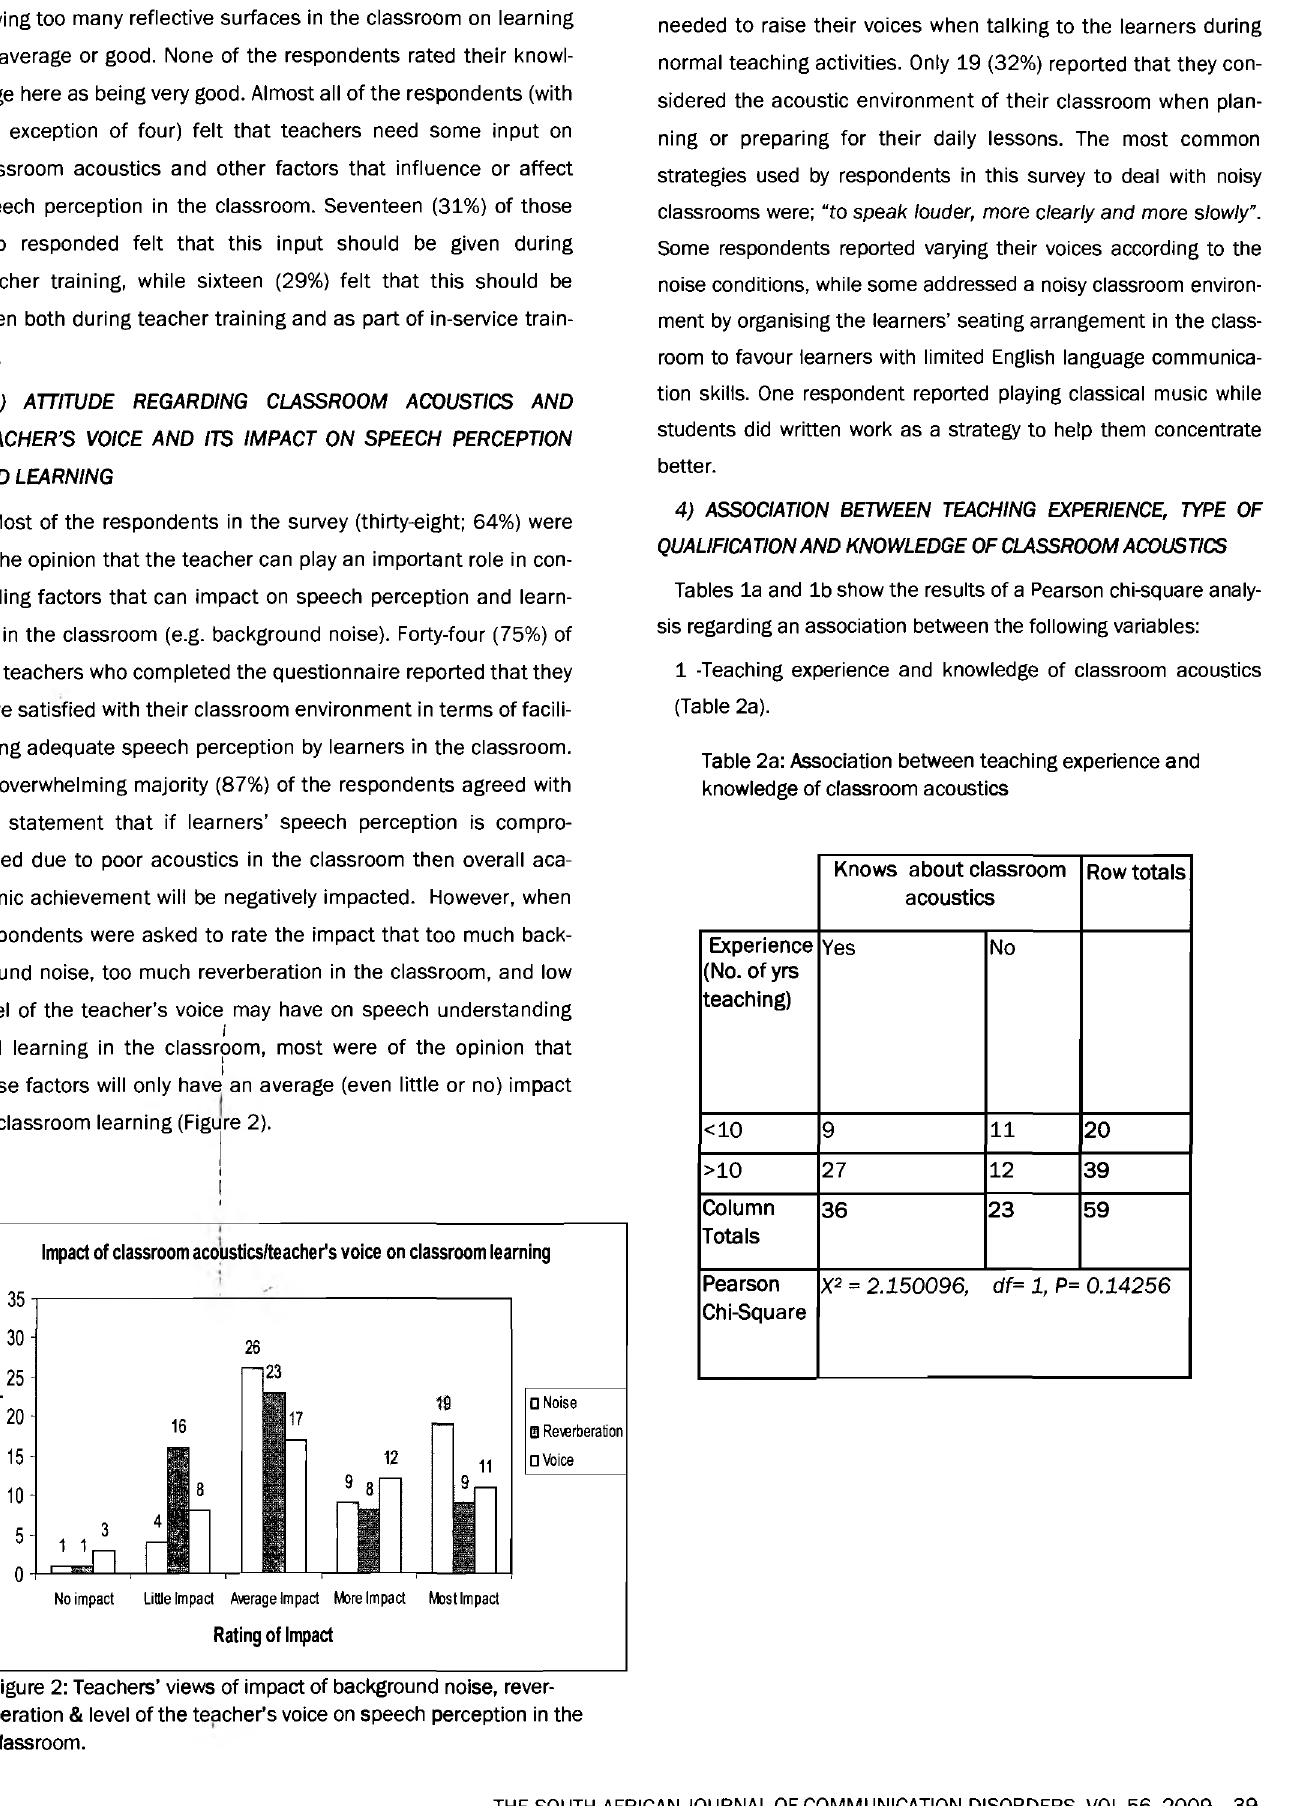
Figure 2: Teachers’ views of impact of background noise, rever­ beration & level of the teacher’s voice on speech perception in the classroom.